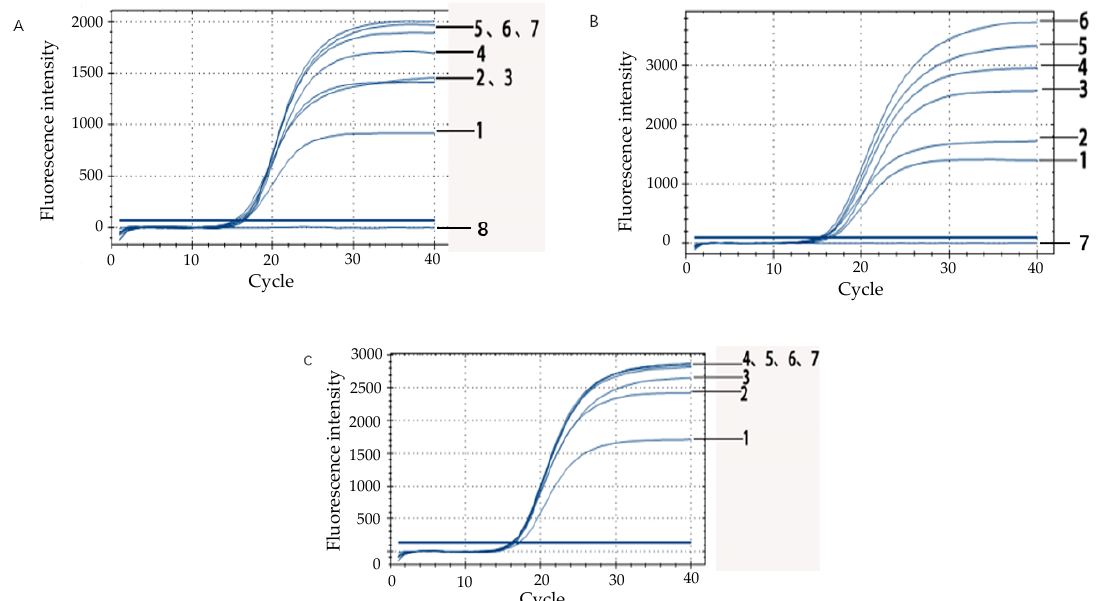
Figure 3. Optimization of real-time fluorescence PCR reaction system. ( A ) Volume improvement of primer based on the rfbE gene. Line 1: 0.4 µ L; Line 2: 0.6 µ L; Line 3: 0.8 µ L; Line 4: 1.0 µ L; Line 5: 1.2 µ L; Line 6: 1.4 µ L; Line 7: 1.6 µ L. Line 8: negative control (PCR reaction system without primer) ( B ) Optimization of probe concentration of target gene in the system. Line 1: 0.3 µ L; Line 2: 0.5 µ L; Line 3: 0.7 µ L; Line 4: 0.9 µ L; Line 5: 1.1 µ L; Line 6: 1.3 µ L; Line 7: negative control (PCR reaction system without probe) ( C ) Annealing temperature optimization of the real-time fluorescence PCR reaction system. Line 1: 64.4 ◦ C; Line 2: 57.3 ◦ C; Line 3: 64.8 ◦ C; Line 4: 61.9 ◦ C; Line 5: 60 ◦ C; Line 6: 58.4 ◦ C; and Line 7: 63.5 ◦